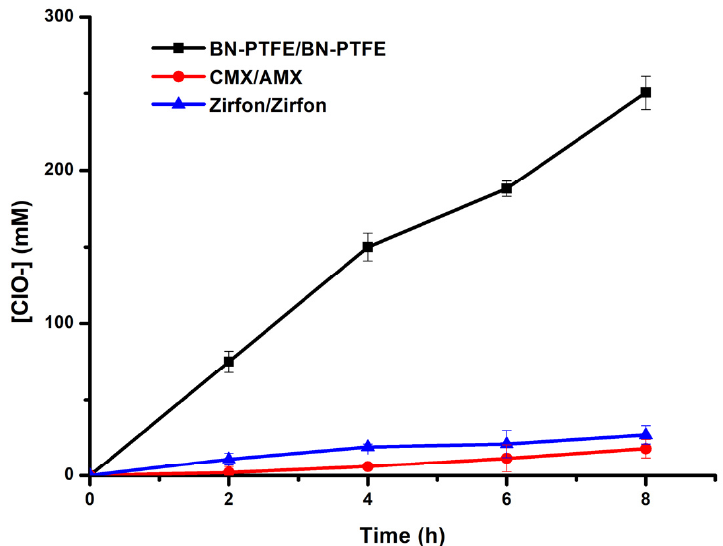
Figure 9. Back-diffusion curves: comparative study of the concentration of hypochlorite ions in the central NaCl compartment using different types of membranes under the same operating conditions (constant flux, room temperature, J = 16.6 mA.cm − 2 , 4.5 < pH Anodic < 5.5).